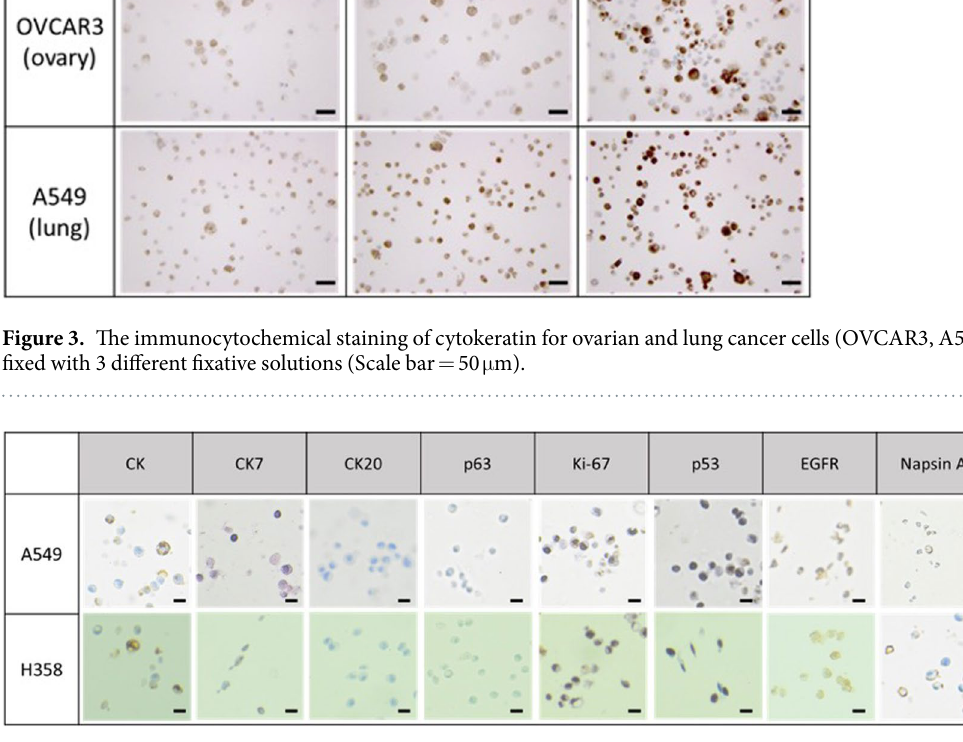
Figure 4. The immunocytochemical stain in lung cancer cell lines cell block (Scale bar = 20 μ